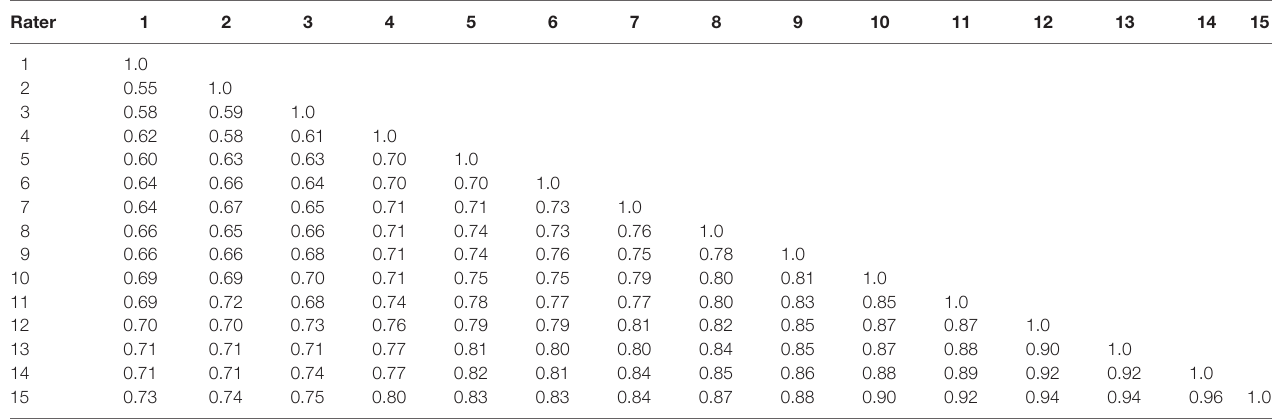
TaBle 1 | Inter-rater correlations for 15 simulated raters.